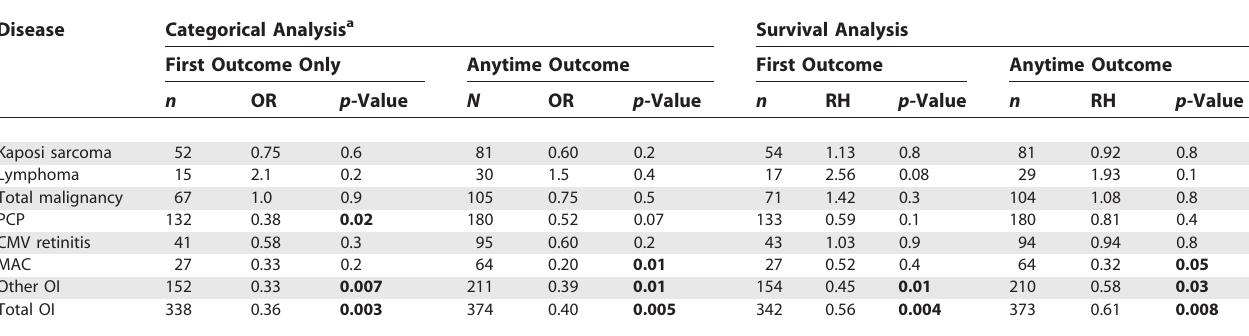
Table 1. Effect of KIR3DS1/Bw4-80I across Distinct Disease Outcomes in HIV-1 Infection